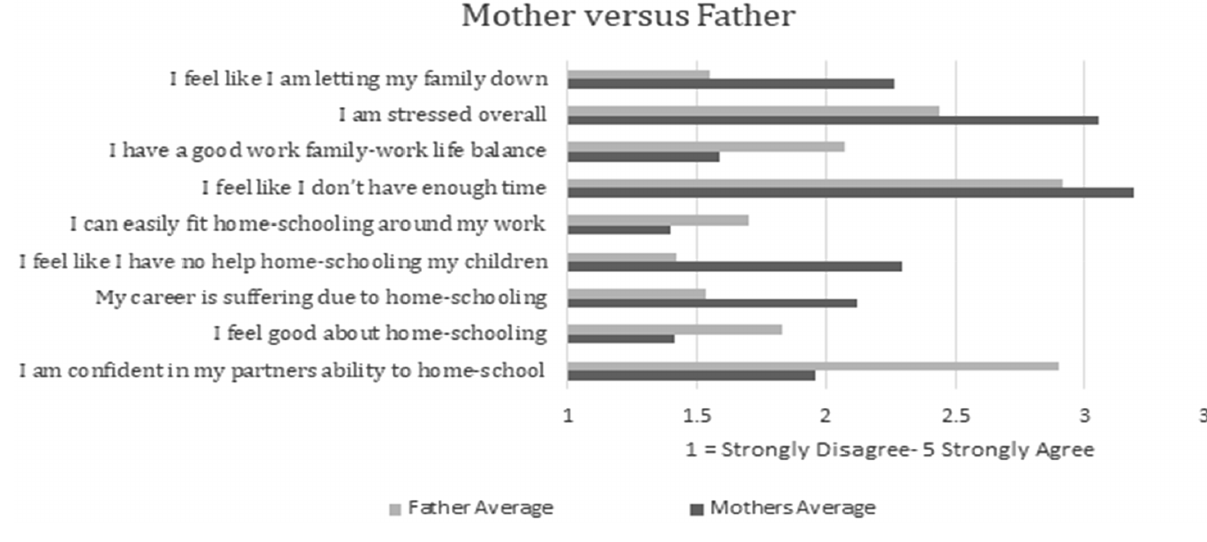
FIGURE 2 | Average ratings differences for questions relating to home-schooling, work–life, and stress for mothers and